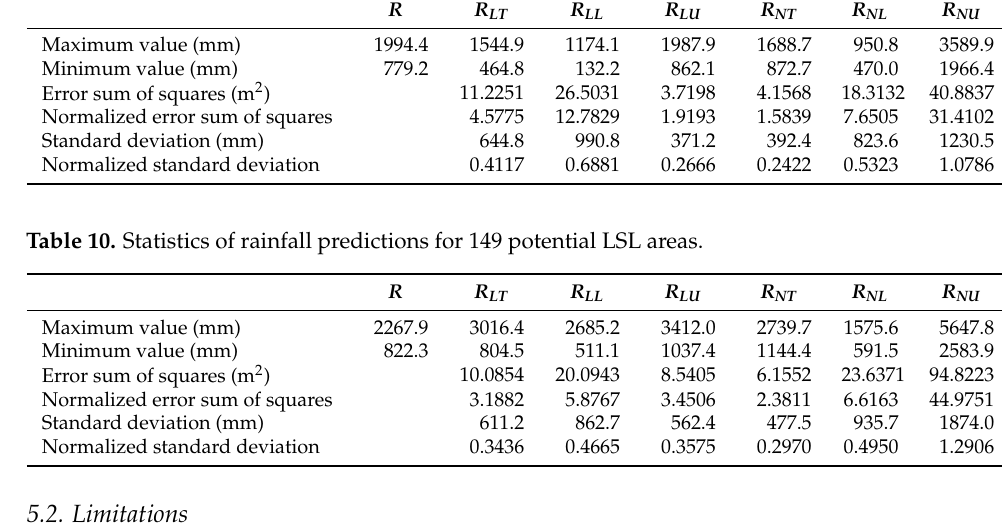
Table 9. Statistics of rainfall predictions for 79 occurrence-time-unknown LSL cases.